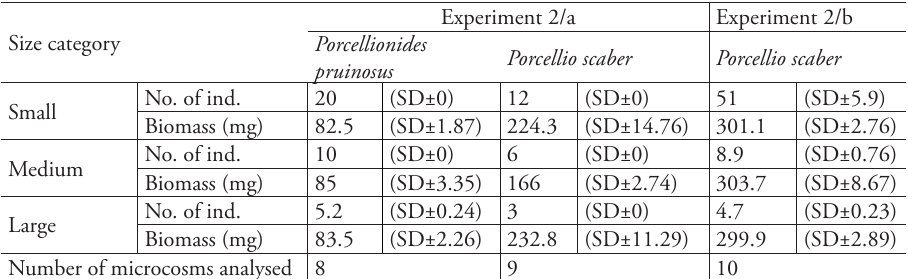
table 1. Mean (±SD) number of isopod individuals, their cumulated biomasses and the number of microcosms used in the experiments.